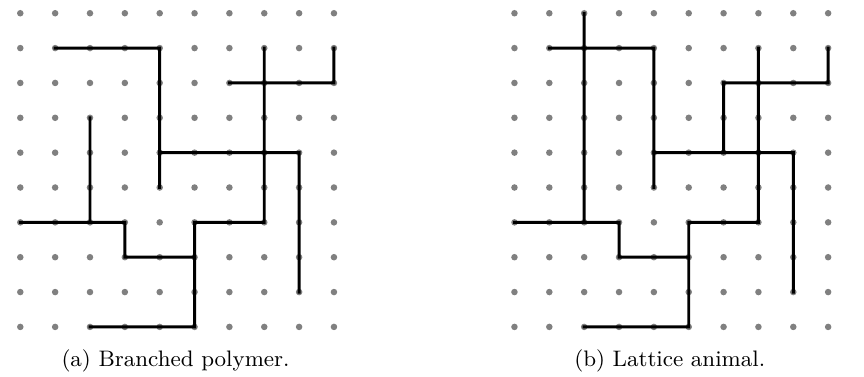
Figure 4 . Different clusters on the